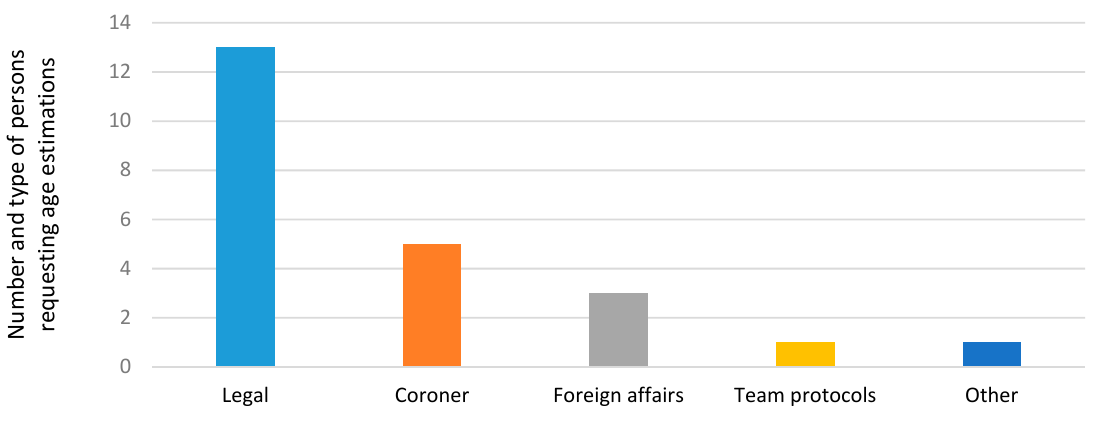
Figure 2. Persons requesting age estimation.